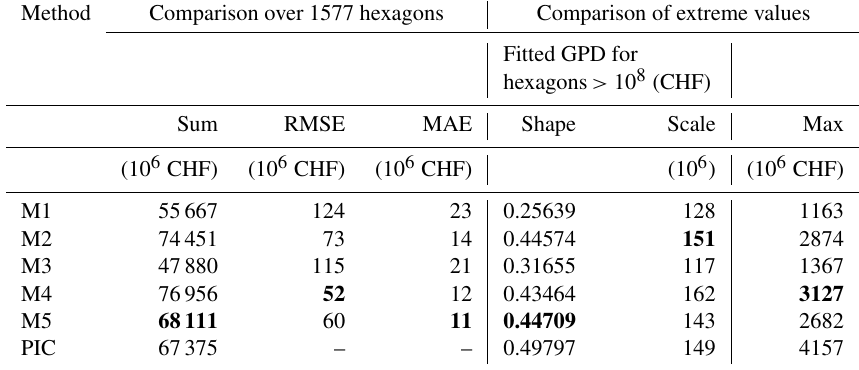
Table 5. Indicators for the comparison of model M1 and M5 with the direct application of insurance data (insured values according to point- referenced building insurance contracts, PIC), in the eight cantons where complete portfolio data of the cantonal insurance companies for building are available. Sum represents the sum of exposed-building values over all 10km 2 hexagons, RMSE and MAE represent the root- mean-square error and the mean-absolute error of exposed-building values per hexagon when comparing M1 to M5 with PIC. The generalized Pareto distribution (GPD) is fitted for hexagons with exposed-building values higher than 10 8 CHF, which is equal to the location parameter of the GPD. Shape and scale represent the respective parameter of the fitted GPD. Max represents the highest sum of exposed-building values per hexagon. Bold numbers indicate the value (of M1–M5) nearest to the value based on PIC. Method Comparison over 1577 hexagons Comparison of extreme